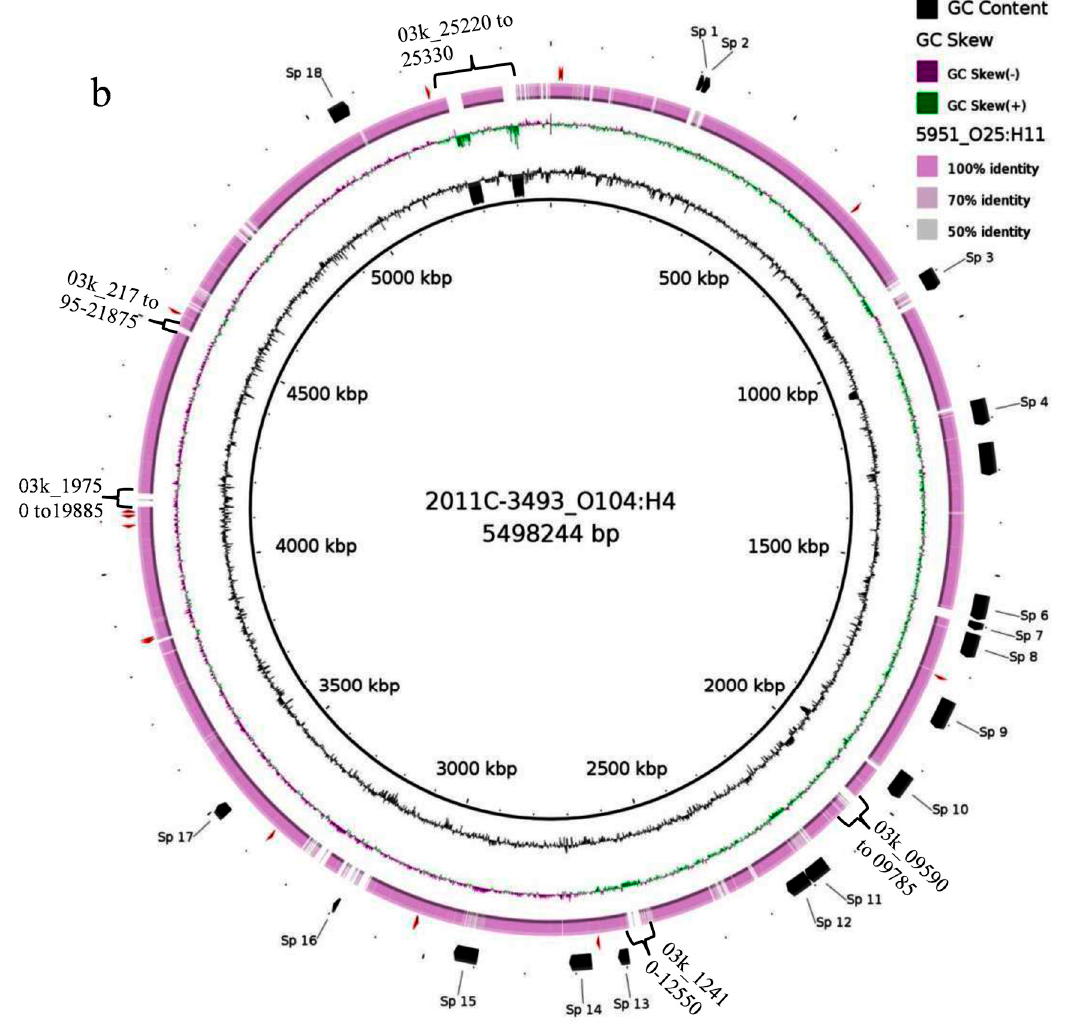
Figure 8. Comparative genomic analysis of ( a ) E. coli O157:H7 (strain EDL933) with E. coli O8:H1 (ID 6297) and ( b ) E. coli 0104:H4 (strain 2011C-3493) with E. coli O25:H11 (ID 5951). The innermost ring shows the reference genomes coverage. The innermost second and third rings show GC content and GC Skew. The outer ring (pink) shows the sequence homology with the reference genomes and the outermost ring highlights the SP sites (prophage regions) annotated in black. The circular plot was generated using BLAST Ring Image Generator (BRIG) software (http://brig.sourceforge.net/).